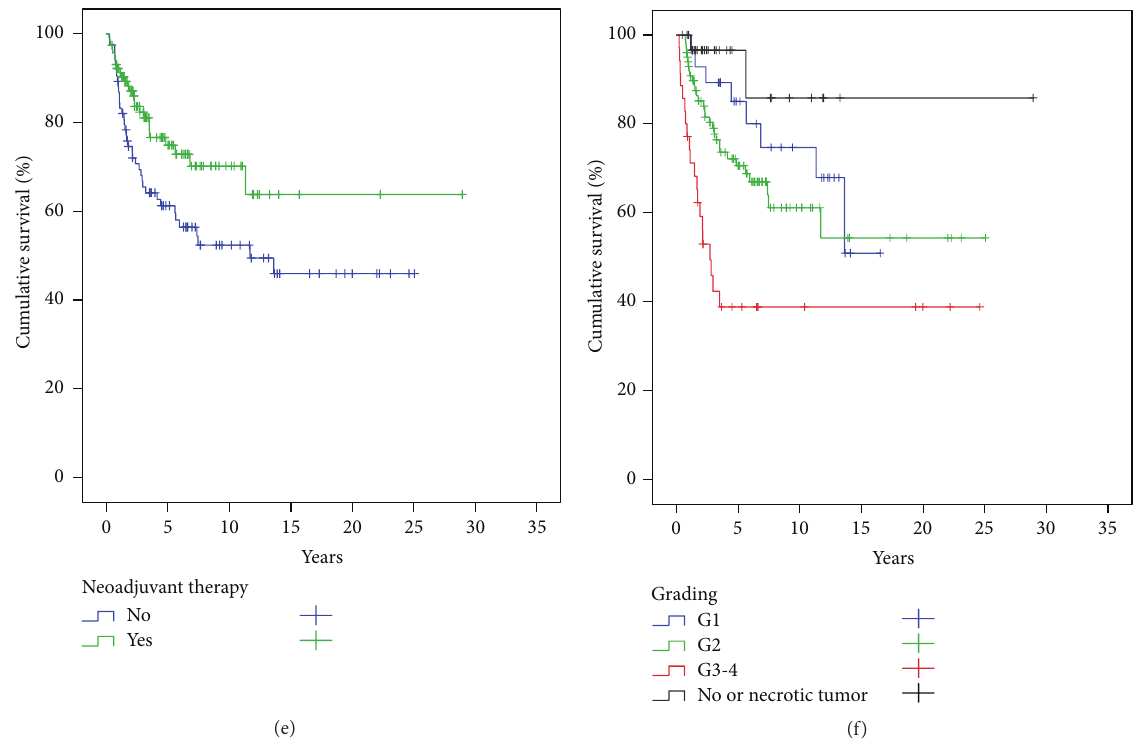
Figure 9: Cumulative survival after LT for HCC (HCC recurrence related deaths only) ( 𝑛 = 199 ) (for statistics see Table 4). (a) With the exception of a better survival comparing the hepatitis C versus cryptogenic cirrhosis subcategories there were no other significant differences forsurvivalrelatedto underlyingdiseases .(b)SurvivalforUICCIandIIstagedtumorswascomparabletothereferencecategory( noornecrotic tumors ), while the risk for HCC recurrence death increased significantly and equivalently with each step of UICC-7 staging above IIIA. (c) Tumors outside the histologic MILAN were significant hazards for survival. Nevertheless, even in the group of patients transplanted outside the histologic MILAN ( hMILAN ) the cumulative survival was 30% at 25 years after liver transplantation. The cumulative survival of patients who were transplanted inside the histologic MILAN ( hMILAN ) was 72% at 30 years after liver transplantation. (d) Small (V1) and large (V2) vascular infiltration were significant hazards for a HCC recurrence related death, while tumors without (V0) vascular infiltration were no significant hazards for survival compared to the reference category of no or necrotic tumors . (e) Neoadjuvant therapy in general decreased the HCC recurrence related death rate significantly. (f) Tumor grading was a significant predictor of survival. While G1 staged tumors had no increased risk for HCC recurrence related death compared to the reference category ( no or necrotic tumors ), G2 and G3-4 graded tumors were identified as significant hazards for HCC recurrence related deaths. The risk to die from HCC recurrence after liver transplantation was twice as high for G3-4 tumors as compared to G2 graded